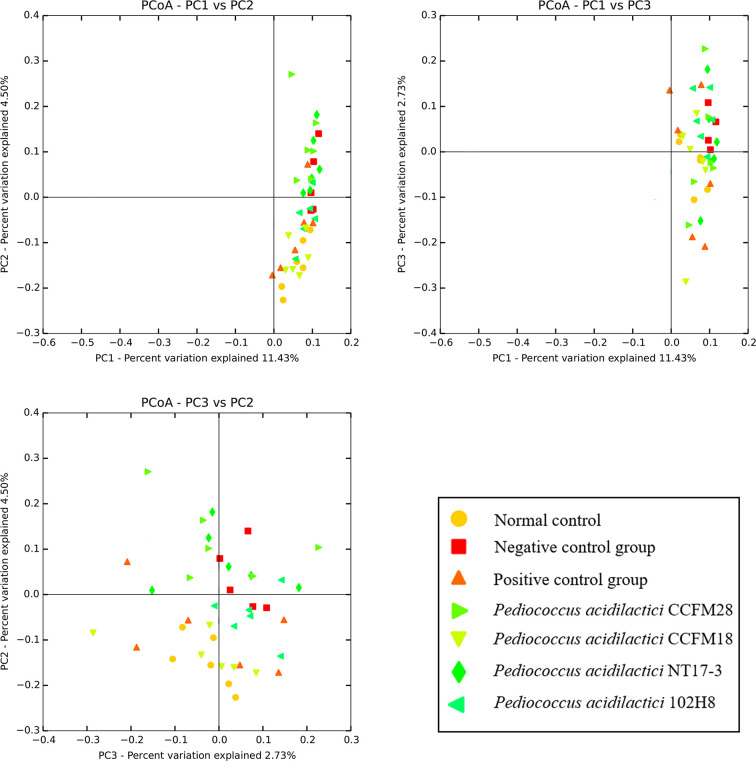
Principal component analysis of microbial communities in mice feces.